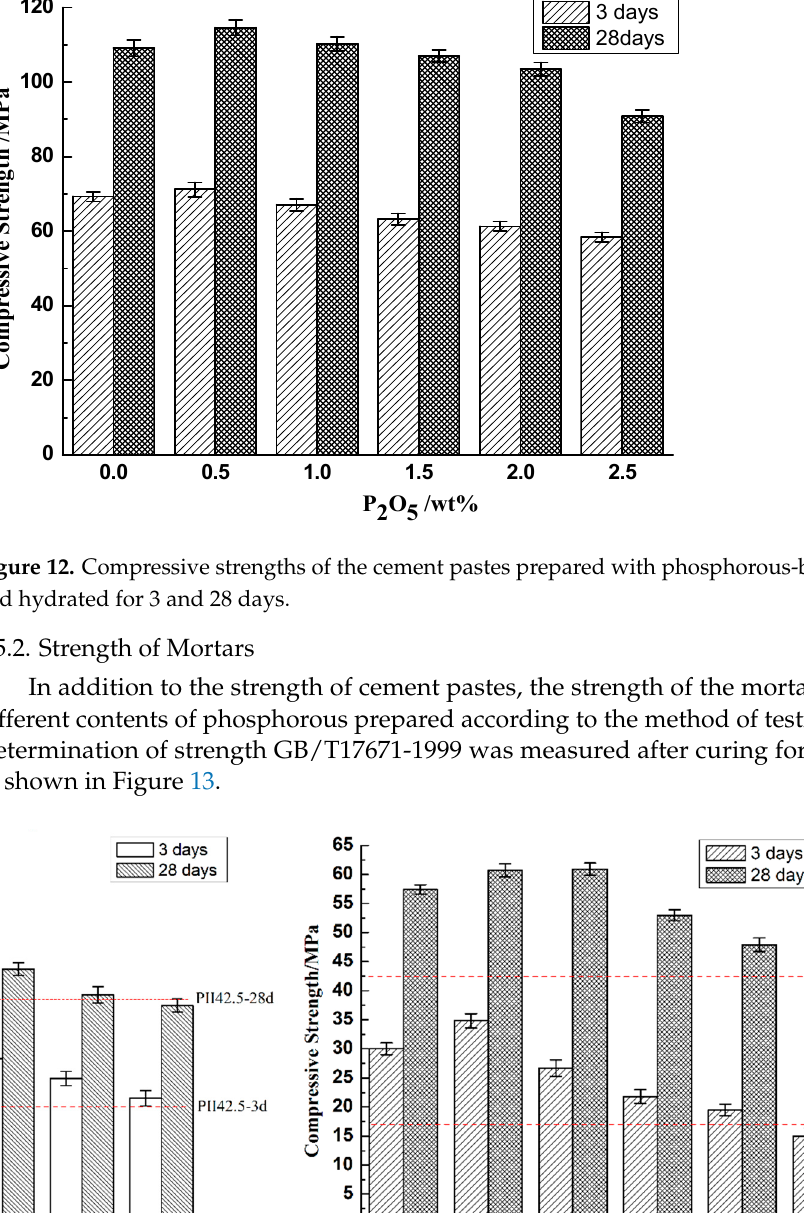
Figure 12. Compressive strengths of the cement pastes prepared with phosphorous-bearing clinkers and hydrated for 3 and 28 days.